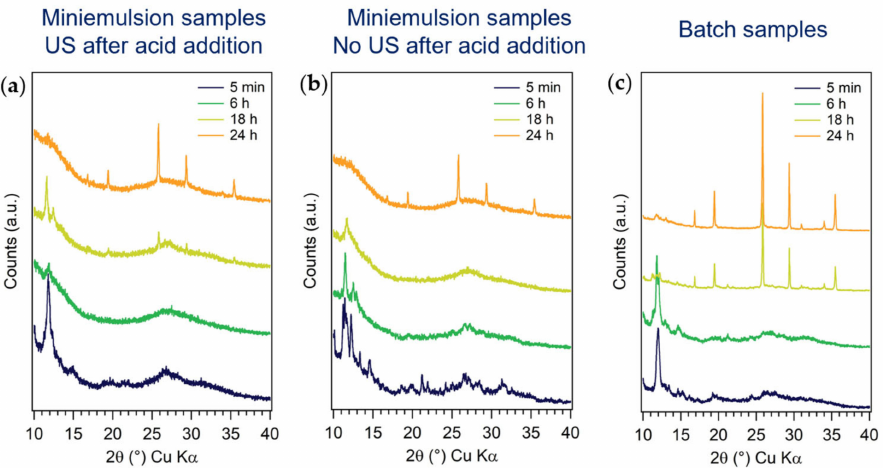
Figure 6. Comparison between XRD patterns of samples obtained in ME ( a ) with and ( b ) without applying US after acid addition and ( c ) in batch, after different reaction times (5 min, 6 h, 18 h, and 24 h). [AHM] = 0.20 M; AHM: HNO 3 1:10